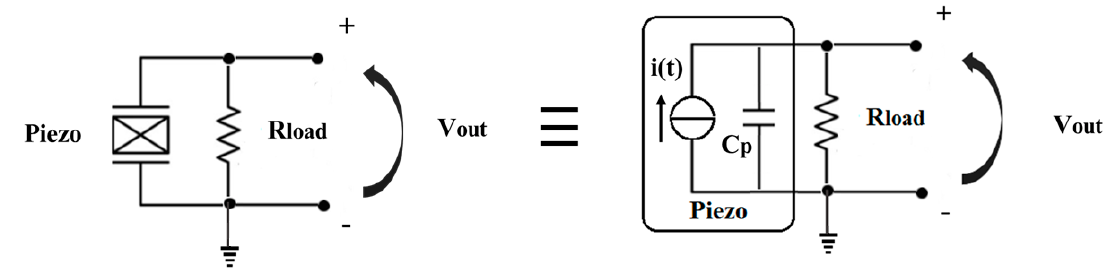
Figure 3. Measurement circuit.